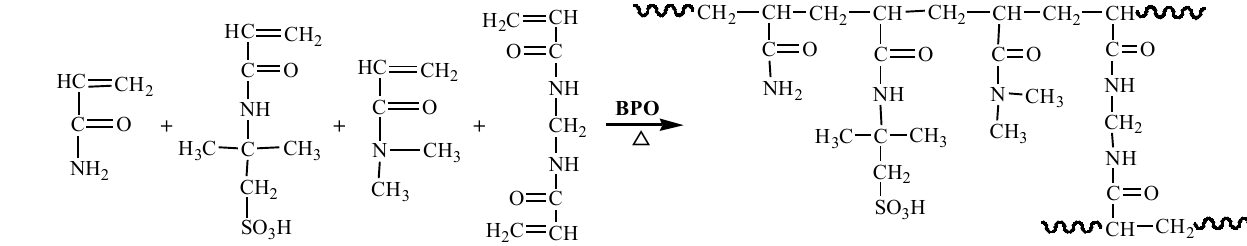
Figure 2. DS-1 synthesis reaction equation.